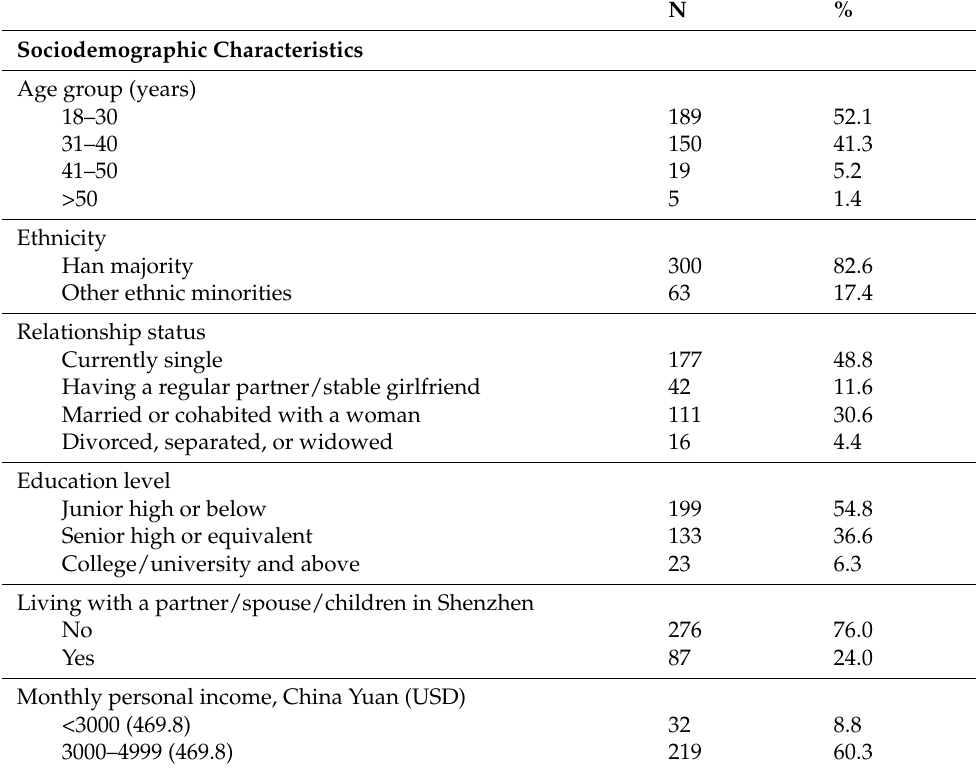
Table 1. Background characteristics of the participants (n =